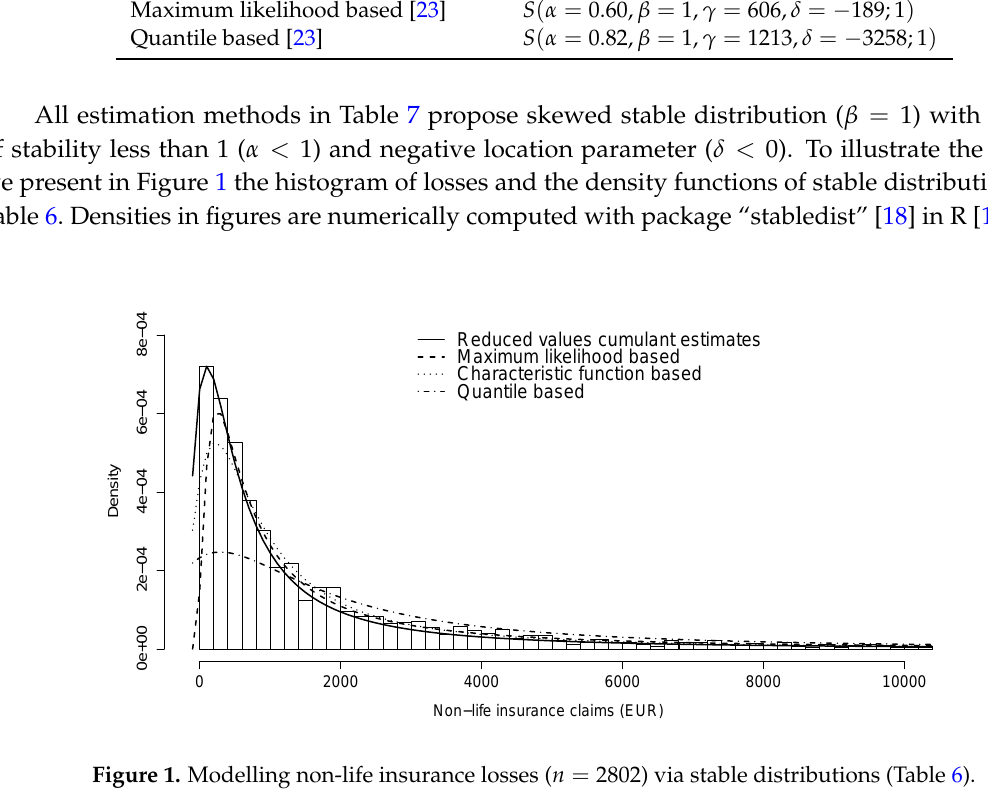
Figure 1. Modelling non-life insurance losses ( n = 2802) via stable distributions (Table